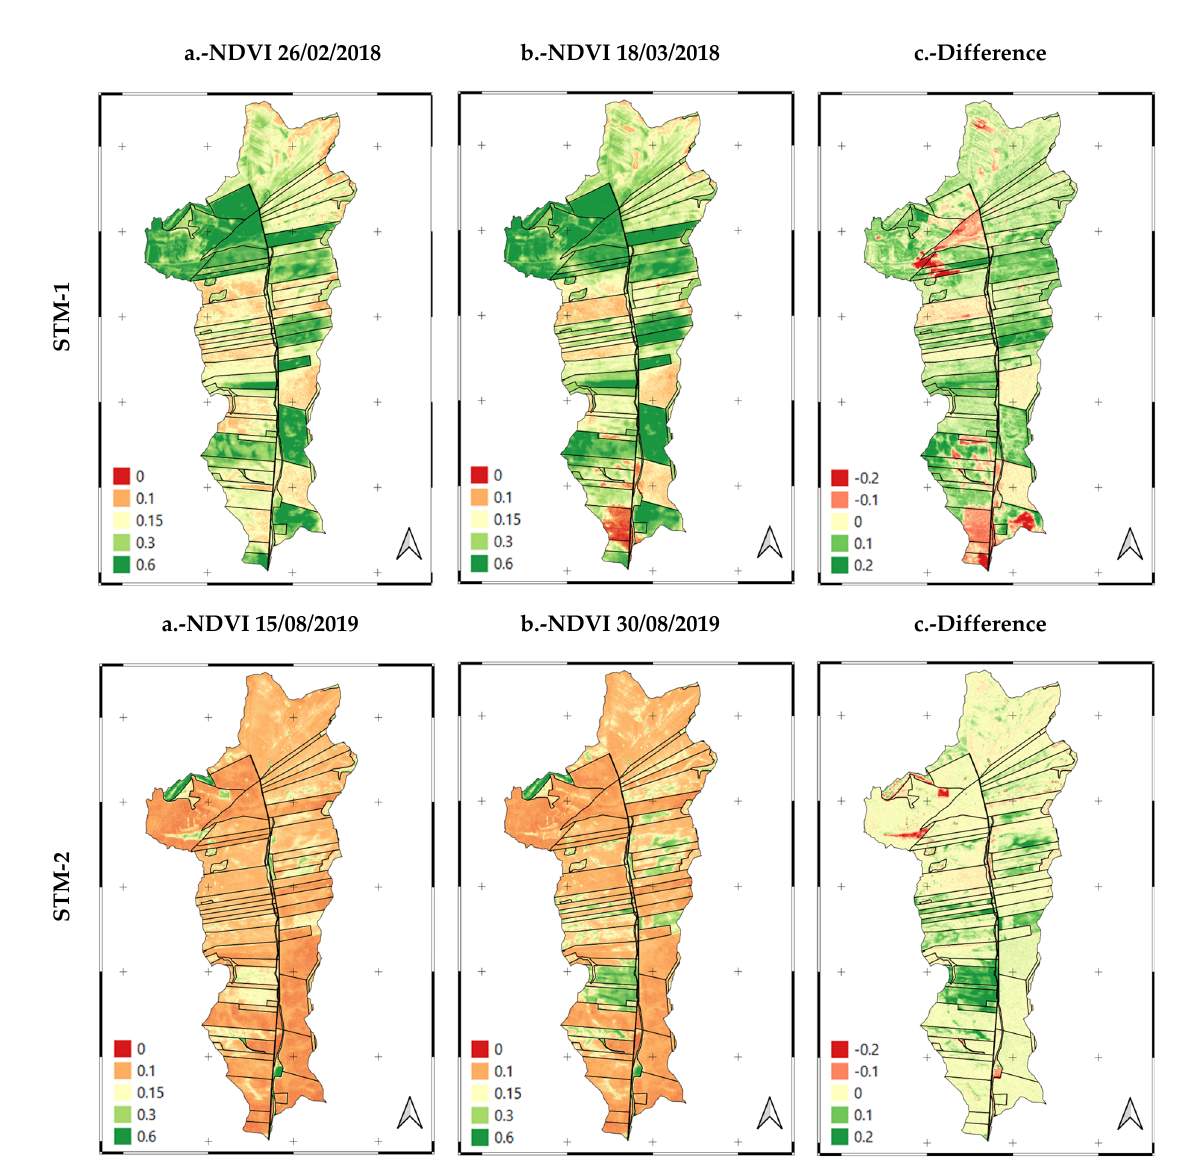
Figure 9. NDVI at the beginning and end of AW-1, 2, and 3 ( a , b ) and NDVI variation ( c ). Zebra frame segments of 1 km. Owing to the erosion expected due to the heavy rainfall, the coherence values of both scenarios STM-1 and STM-2 (Figure 10) were low, as erosion corresponds to the temporal factor, an unavoidable component of coherence loss. A different coherence behaviour is observed between plots with and without vegetal coverage in scenario STM-1. As can be seen, the greener areas in Figure 9a,b (higher NDVI index and more developed vegetation coverage) correspond to the highest coherence values in Figure 10, while the red-orange areas in Figure 9a,b (lower NDVI index, fallow land) correspond to the lowest coherence values in Figure 10. The basin in scenario STM-1 had a mean coherence value of 0.437, a standard deviation of 0.174, and a maximum of